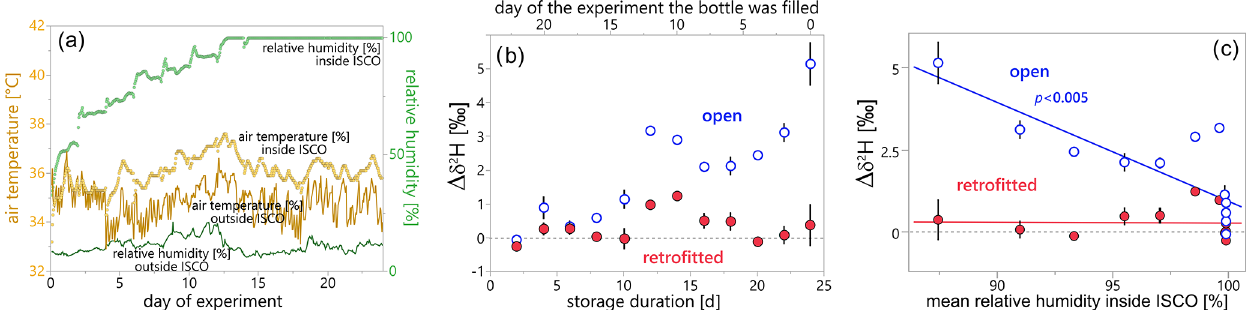
Figure 2. (a) Evolution of air temperature (yellow) and relative humidity inside (light green) and outside (dark green) the ISCO autosampler during Experiment 1. Humidity outside the ISCO autosampler stayed relatively constant between 6% and 21%, whereas humidity inside the sampler increased over time to 100%. Average air temperature was similar inside and outside, but fluctuations were more pronounced outside the autosampler. (b) The isotopic enrichment of the sample water relative to the reference water (here expressed as isotopic difference (cid:49)δ 2 H) was stronger for samples in open bottles (open blue circles) and increased with longer storage durations. The isotopic difference was calculated for each sample relative to the isotopic composition of the reference water in the storage tank on the day the bottle was filled (Eq. 4). (c) Isotopic difference in water samples relative to the reference water as a function of the mean relative humidity, which represents the average of relative humidity values during the full storage duration of each bottle. The linear regression (solid line) for the open bottles is statistically significant at p < 0 . 005; the regression slope for the retrofitted bottles is not statistically different from zero. In (b) and (c) , water samples in open bottles are marked with blue open circles, whereas water samples in retrofitted bottles are marked with red filled circles. Error bars indicate the measurement uncertainty as ± 1 standard deviation.